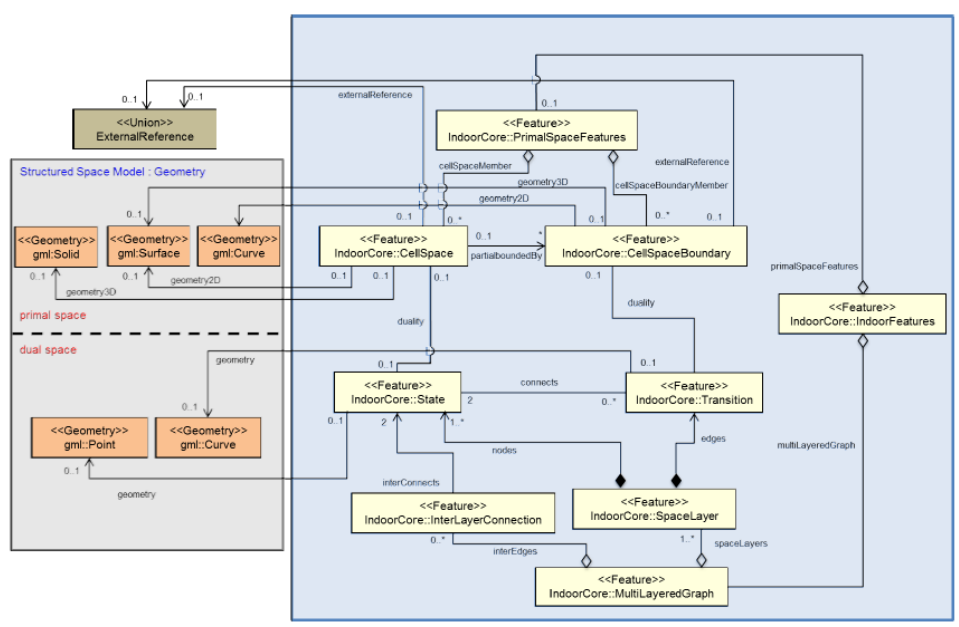
Figure 2. IndoorGML core module data model (OGC,